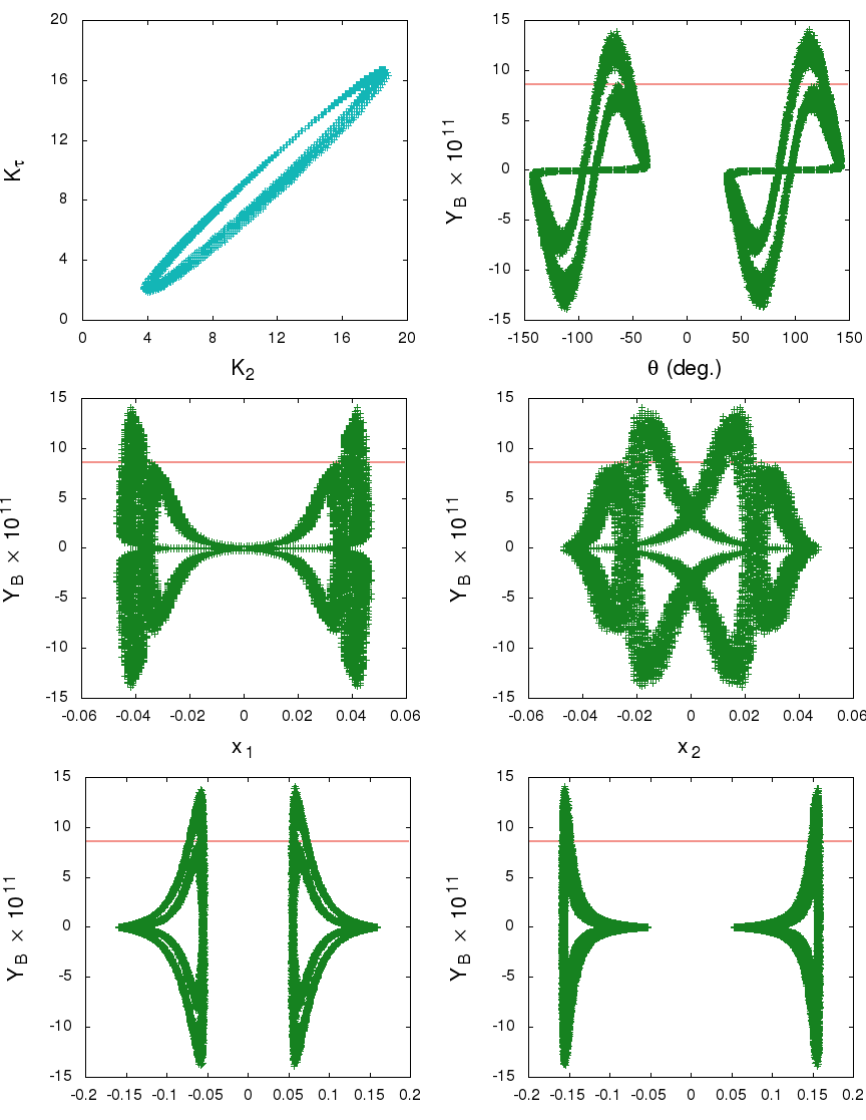
Figure 3 . The (cid:12)rst (cid:12)gure the left panel shows the ranges for the washout parameters. Rest of the plots represent the variation of Y B with the rescaled parameters for a representative value M 1 = 10 11 GeV.